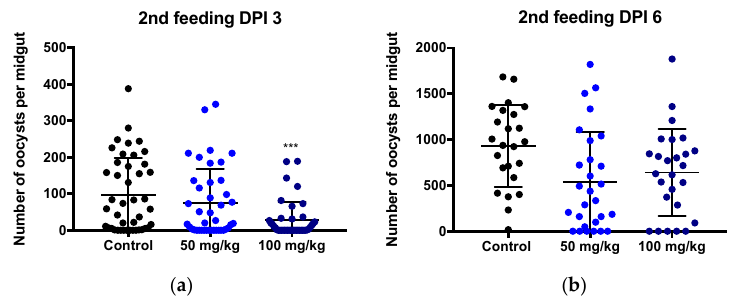
Figure 2. Exposure to MB during Plasmodium mosquito stage development shows a moderate impact on oocyst numbers. Preliminary P. berghei -infected mosquitoes were divided into three groups that received secondary blood meals on anesthetized mice treated with 0 (control, black dot), 50 (light blue dot) and 100 (dark blue dot) mg/kg MB 3 days ( a ) and 6 days ( b ) pi. The infection intensity is presented as the number of oocysts per midgut (black dots). The black lines represent the mean and standard deviation. Data are represented from two independent experiments. *** p = 0.005 when compared to the control by t -test.